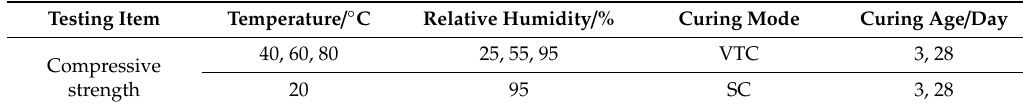
Figure 2. Curing device and temperature curing curve under VTC condition. ( a ) curing box, ( b ) curing temperature curve. Table 4. Experimental conditions.